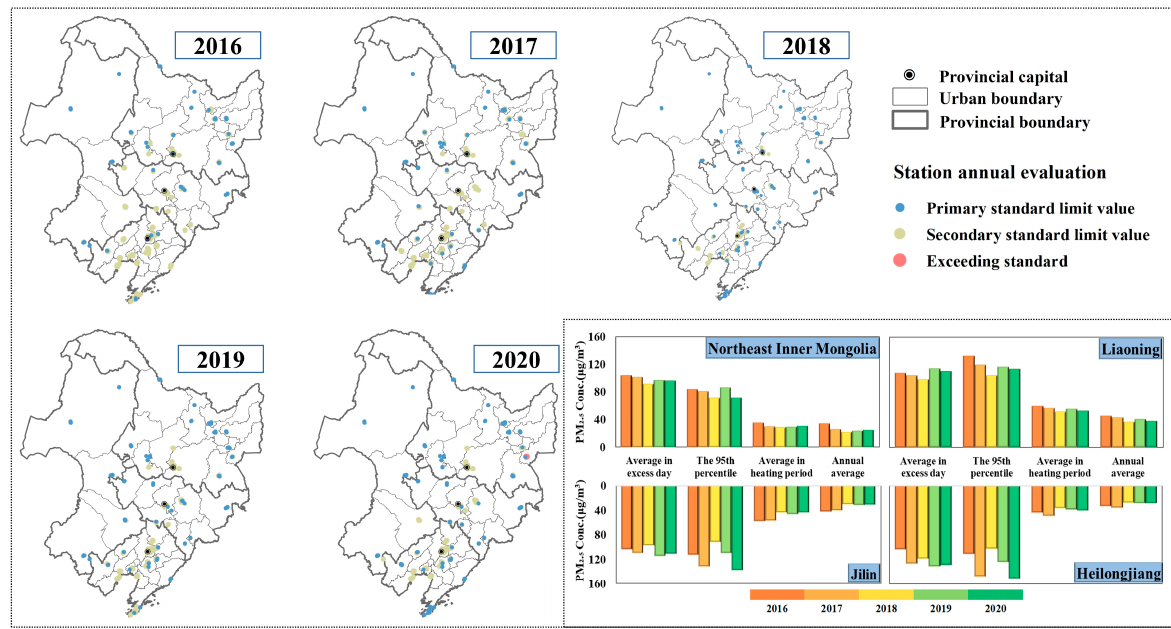
Figure 2. Annual average PM 2.5 concentration compliance of air quality monitoring stations in Northeast China from 2016 to 2020. The four combined PM 2.5 pollution indicators for each of the four regions (Northeast Inner Mongolia, Liaoning, Jilin and Heilongjiang) are shown in the bar chart.